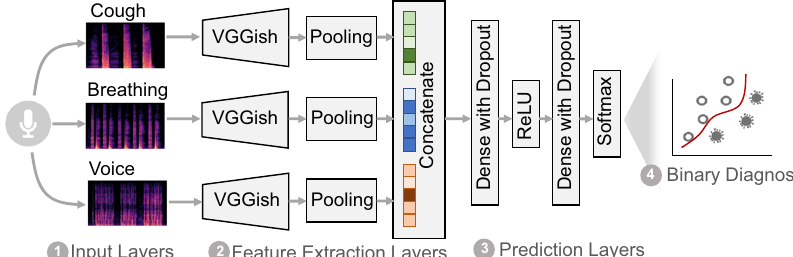
Fig. 5 Overview architecture of the deep learning model. A convolutional neural network using cough, breathing, and voice sounds as input, to predict COVID-19 as a binary outcome. VGGish is a neural network pre-trained on the Audioset dataset, Pooling is an aggregation operator, Dense is a fully connected neural network layer, Dropout is a randomised operation that reduces over fi tting, ReLU is a recti fi ed linear unit activation, Softmax is the logistic